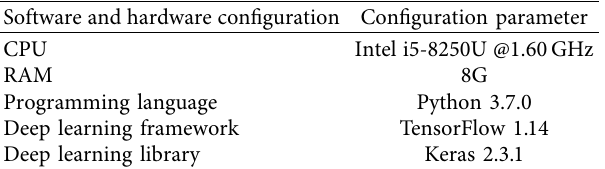
Table 1: Experimental environment.